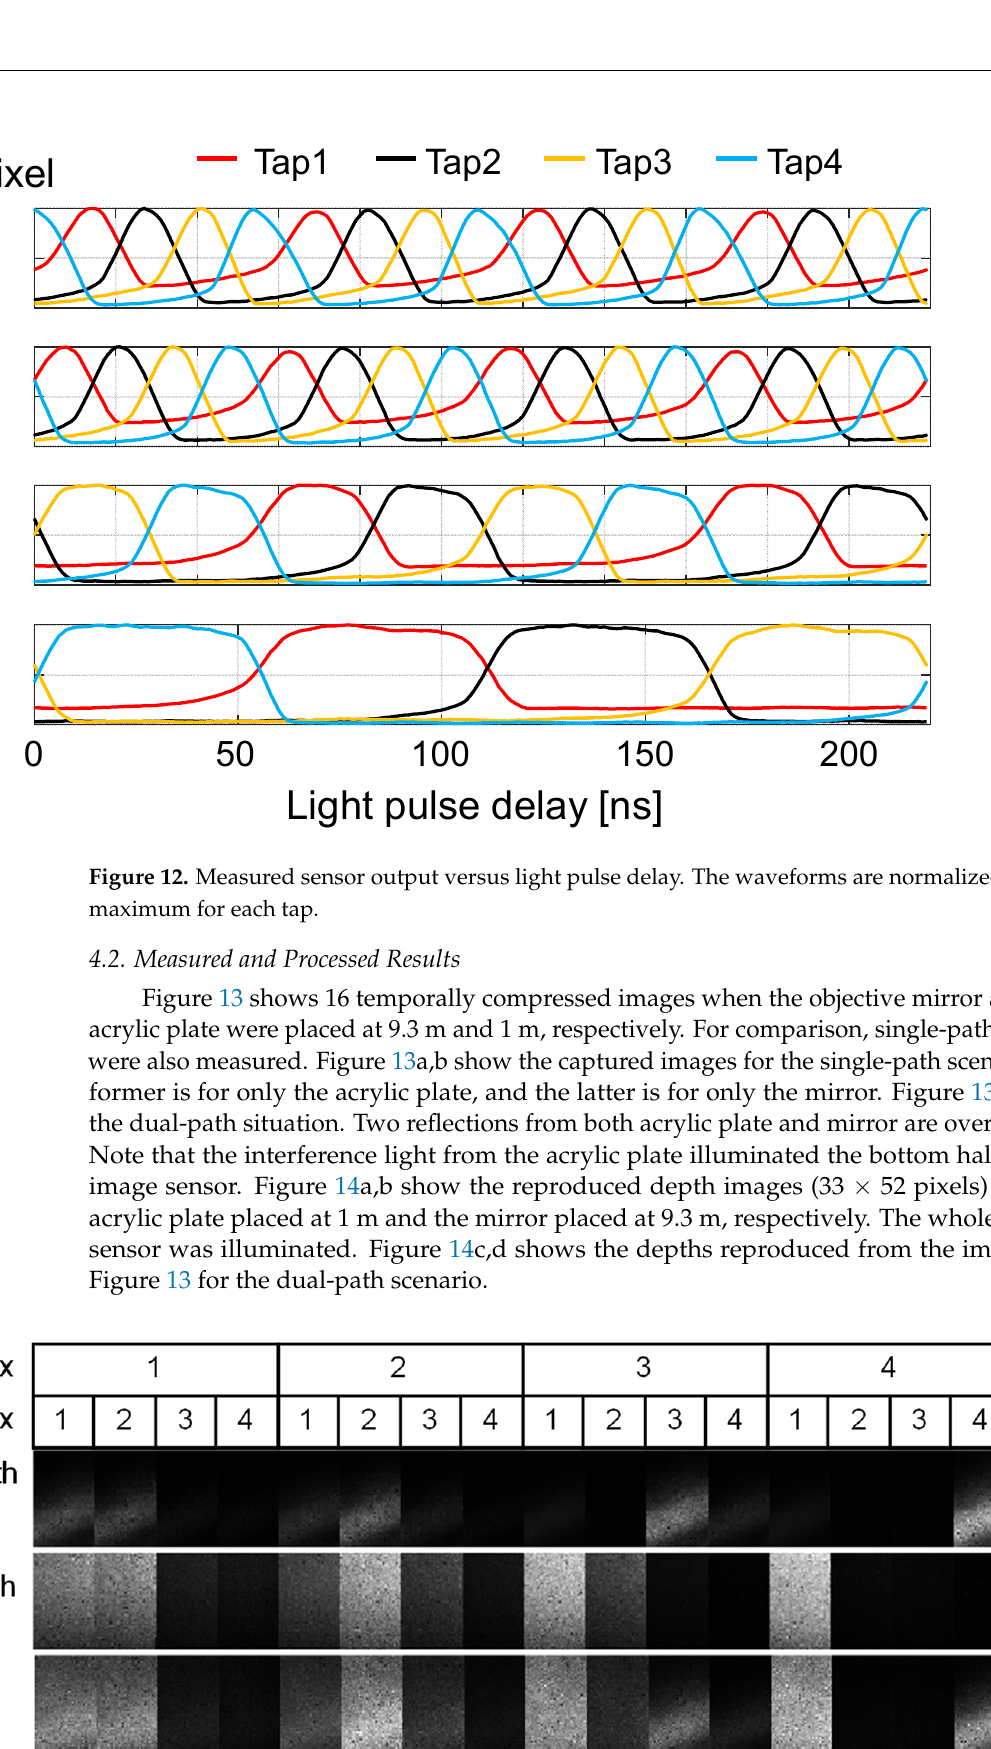
13 of 18 Figure 11. Experimental setup for dual-path ToF depth imaging. The objective mirror and transpar- ent acrylic plate constitute dual-path interference. The correlation of the total system response of the ToF camera system and the coded shutters, which was equivalent to the sensor output 𝒑 , was measured before the ToF im- aging. The measurement was performed while the emission timing delay of the pulsed laser 𝑡 was scanned over the measurable range. The measured functions are denoted as follows: 𝑝′ (cid:3040) (𝑡) = (cid:3505) 𝑤 (cid:3040) (𝜉) 𝐿(𝜉 − 𝑡)𝑑𝜉. (13) The measured responses shown in Figure 10 were used in every step of the inverse problem solving. The measurement matrix 𝑨 was generated by down-sampling {𝑝′ (cid:3040) (𝑡)} , and the sensor output in the refinement stage was given by the superposition of